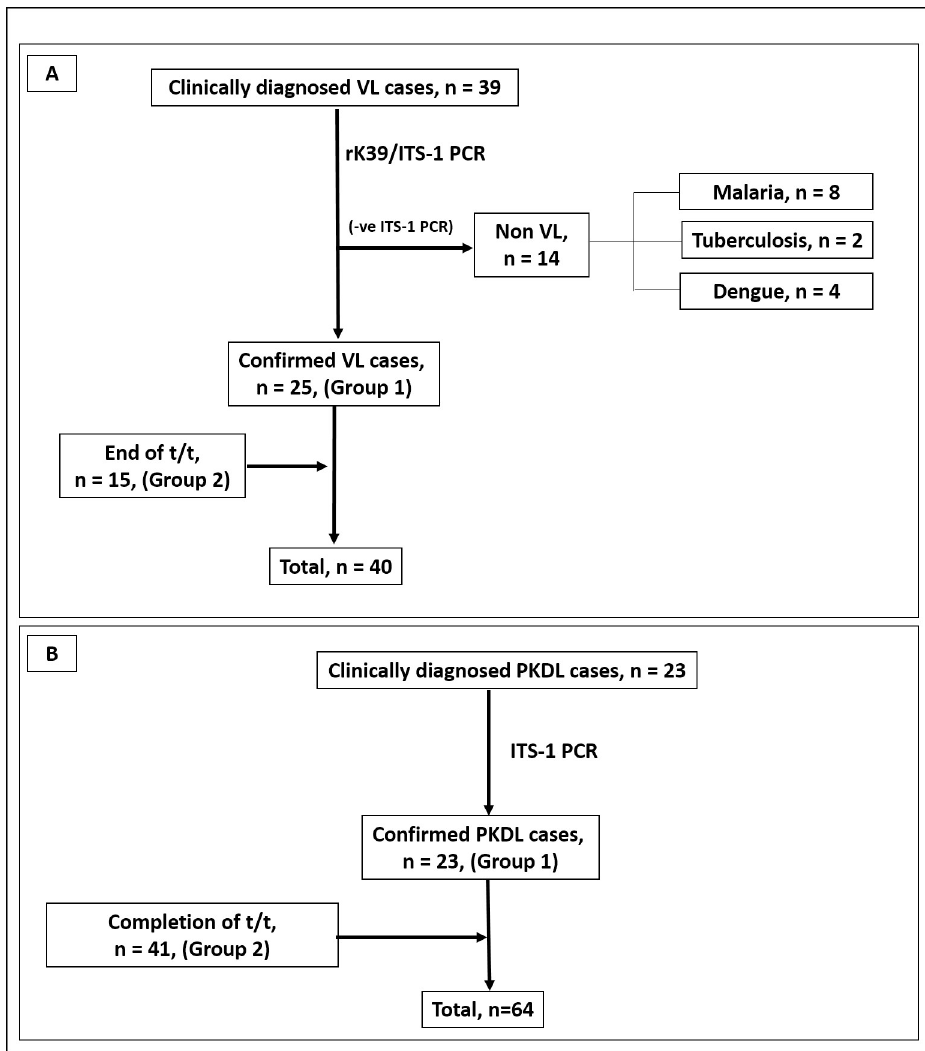
Fig 1. Schematic diagram indicating enrolment of patients with visceral leishmaniasis (VL, A ) and post kala-azar dermal leishmaniasis (PKDL, B ) that were tested by qPCR and RPA as described in materials and methods. Patients with VL/PKDL were recruited at disease presentation (Group 1) or at completion of treatment (Group 2). The diagnostic potential of the RPA assay was reiterated with Group 1, while the prognostic potential was evaluated with Group 2. t/t: